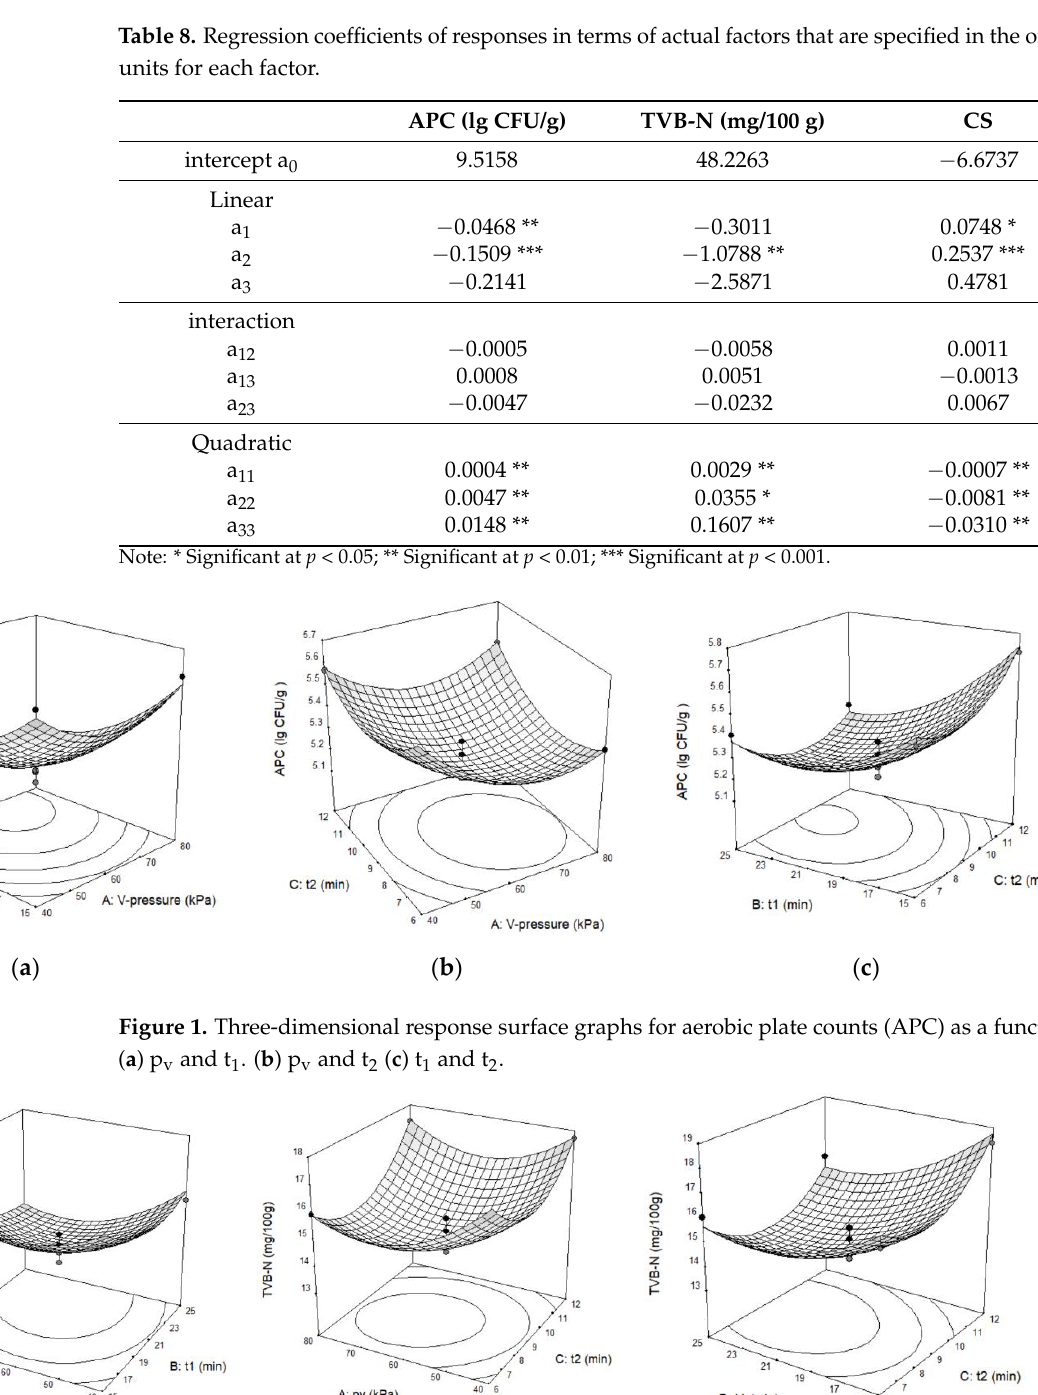
( c ) Figure 3. Three-dimensional response surface graphs for comprehensive score (CS) as a function of ( a ) p v and t 1 . ( b ) p v and t 2 . ( c ) t 1 and t 2. 3.2.2. Optimisation of the Process Variables Using a numerical optimization strategy based on the desirability approach and De- sign Expert 8.0 software, the optimal settings of the independent variables for VI technol- ogy were identified. The optimisation criterion for restrictions was to minimise APC and TVB-N while maximising CS. The independent variables for the optimization technique were kept within the experimental range. The optimised values for p v , t 1 , and t 2 were 67.73 kPa, 23.66 min, and 8.87 min, respectively. The estimated APC, TVB-N, and CS values under ideal conditions were 5.17 lg CFU/g, 14.04 mg/100 g, and 0.98, respectively. To ac- commodate laboratory operations, experiments were conducted in triplicate with the